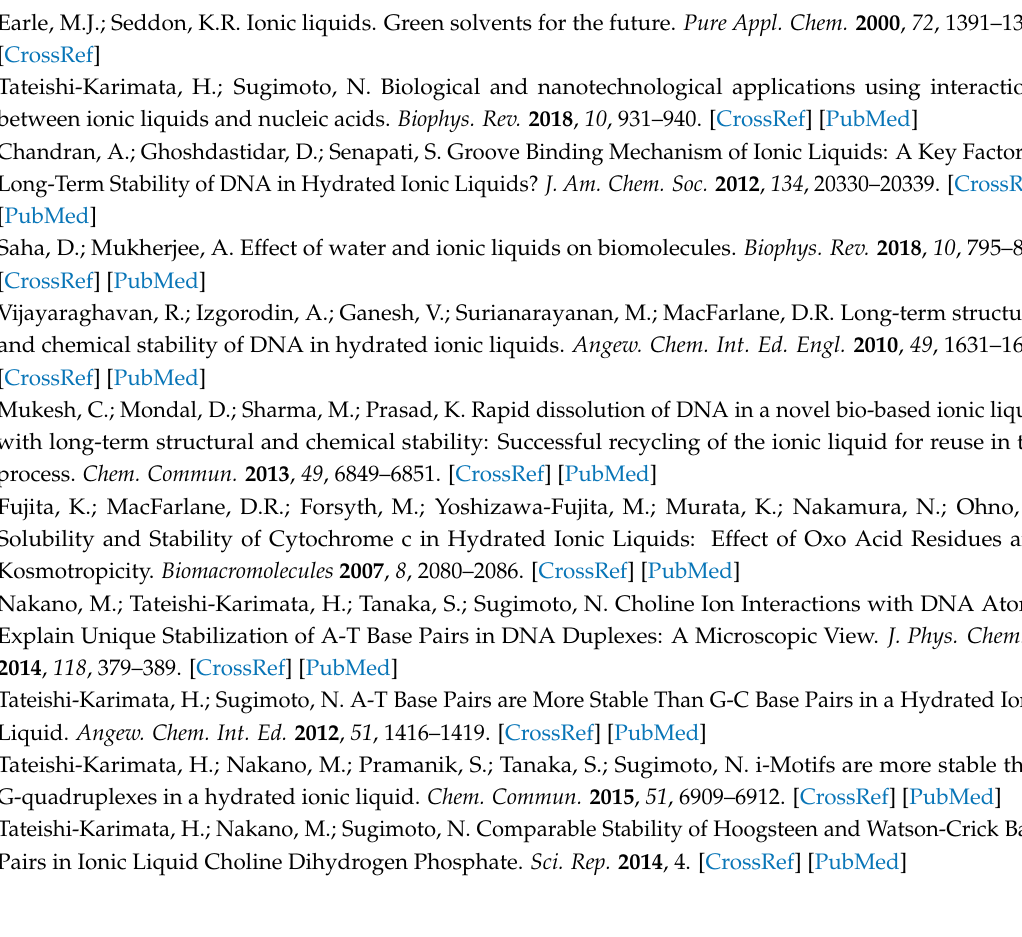
Supplementary Materials: The following are available online. Figure S1: The excitation spectrum of C12-Ag NCs at 557 nm in 3.0 M choline dhp (pH 7.0) at 25 ◦ C. Figure S2. (a) The fluorescence spectra of C12-Ag NCs excited at 470 nm (solid) and 540 nm (dash) in the buffers containing 0, 0.1, 0.3, 0.5, 1.0, 2.0 and 3.0 M choline-dhp-NaOH (pH 7.0) at 25 ◦ C. (b) The normalized fluorescence intensity of C12-Ag NCs of 557 nm at 470 nm excitation (black) and of 577 nm at 540 nm excitation (red) in the buffers containing 0, 0.1, 0.3, 0.5, 1.0, 2.0 and 3.0 M choline-dhp-NaOH (pH 7.0) at 25 ◦ C. Figure S3. (a) The fluorescence spectra of 3endC12-Ag NCs at 25 ◦ C